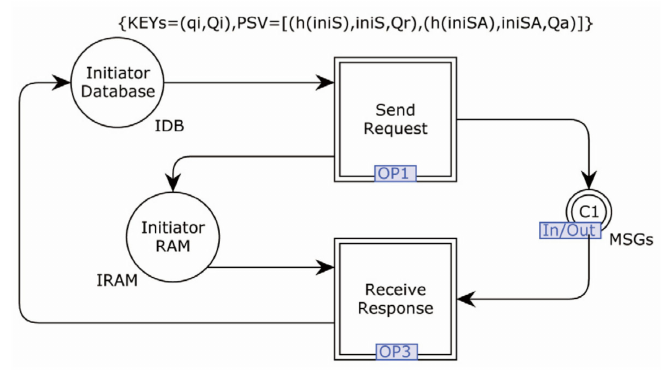
Figure 6. The second-layer model of